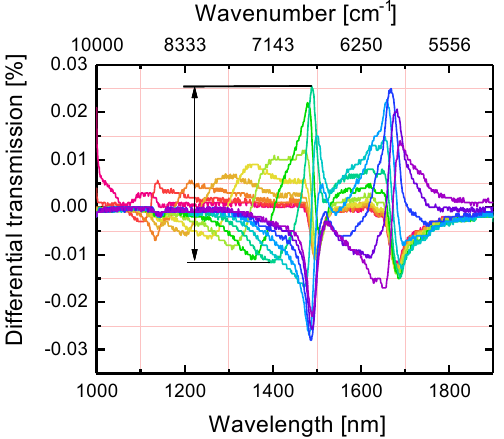
Figure 5. Differential transmission (DT) of metasurfaces with 100 nm thick analyte overlayers. The length of NPs varies from 100 (crimson curve) to 220 (purple curve) nm with steps of 10 nm while the lattice periods are of Λ 1 = 400 nm and Λ 2 = 200 nm. The DT contrast is defined as the difference between the maximum and minimum values of DT in the spectral range of the N-H overtone transition and is shown by an arrow for one of the metasurfaces.